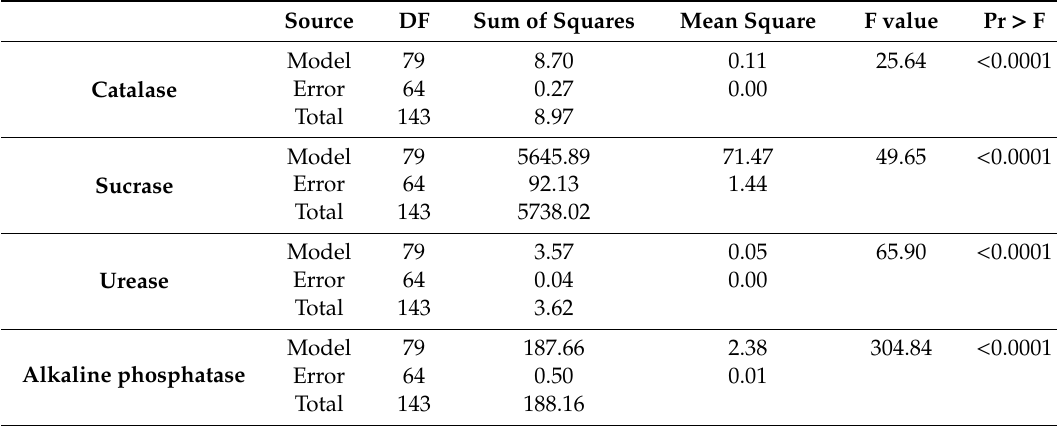
Table 3. ANOVA tables of soil enzyme activities. Factors include years (April, June, August, and October), lands (CK40, CK30, CK15, and SC) and soil depth (0–10, 10–20, and 20–30